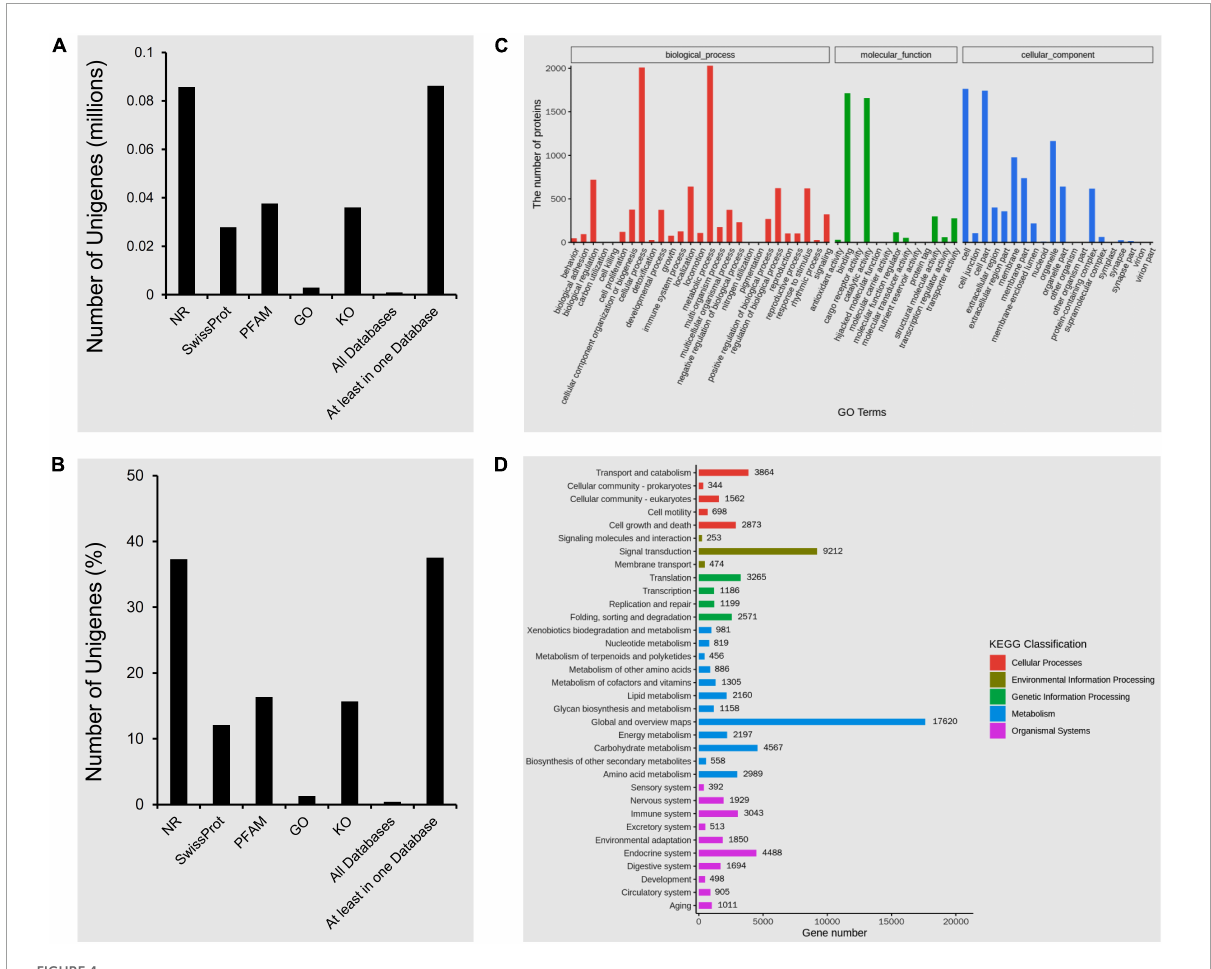
FIGURE4 Functional annotation of DEGs. (A) The number of unigenes annotated in different databases; (B) percentage of unigenes annotated in NR, SwissProt, PFAM, GO and KO databases; (C) Gene ontology (GO) enrichment analysis of DEGs. GO analysis characterized the DEGs under biological process (BP), molecular function (MF) and cellular component (CC) categories; (D) KEGG analysis of DEGs from VF and AVF whiteflies represents the number of genes associated with five functional